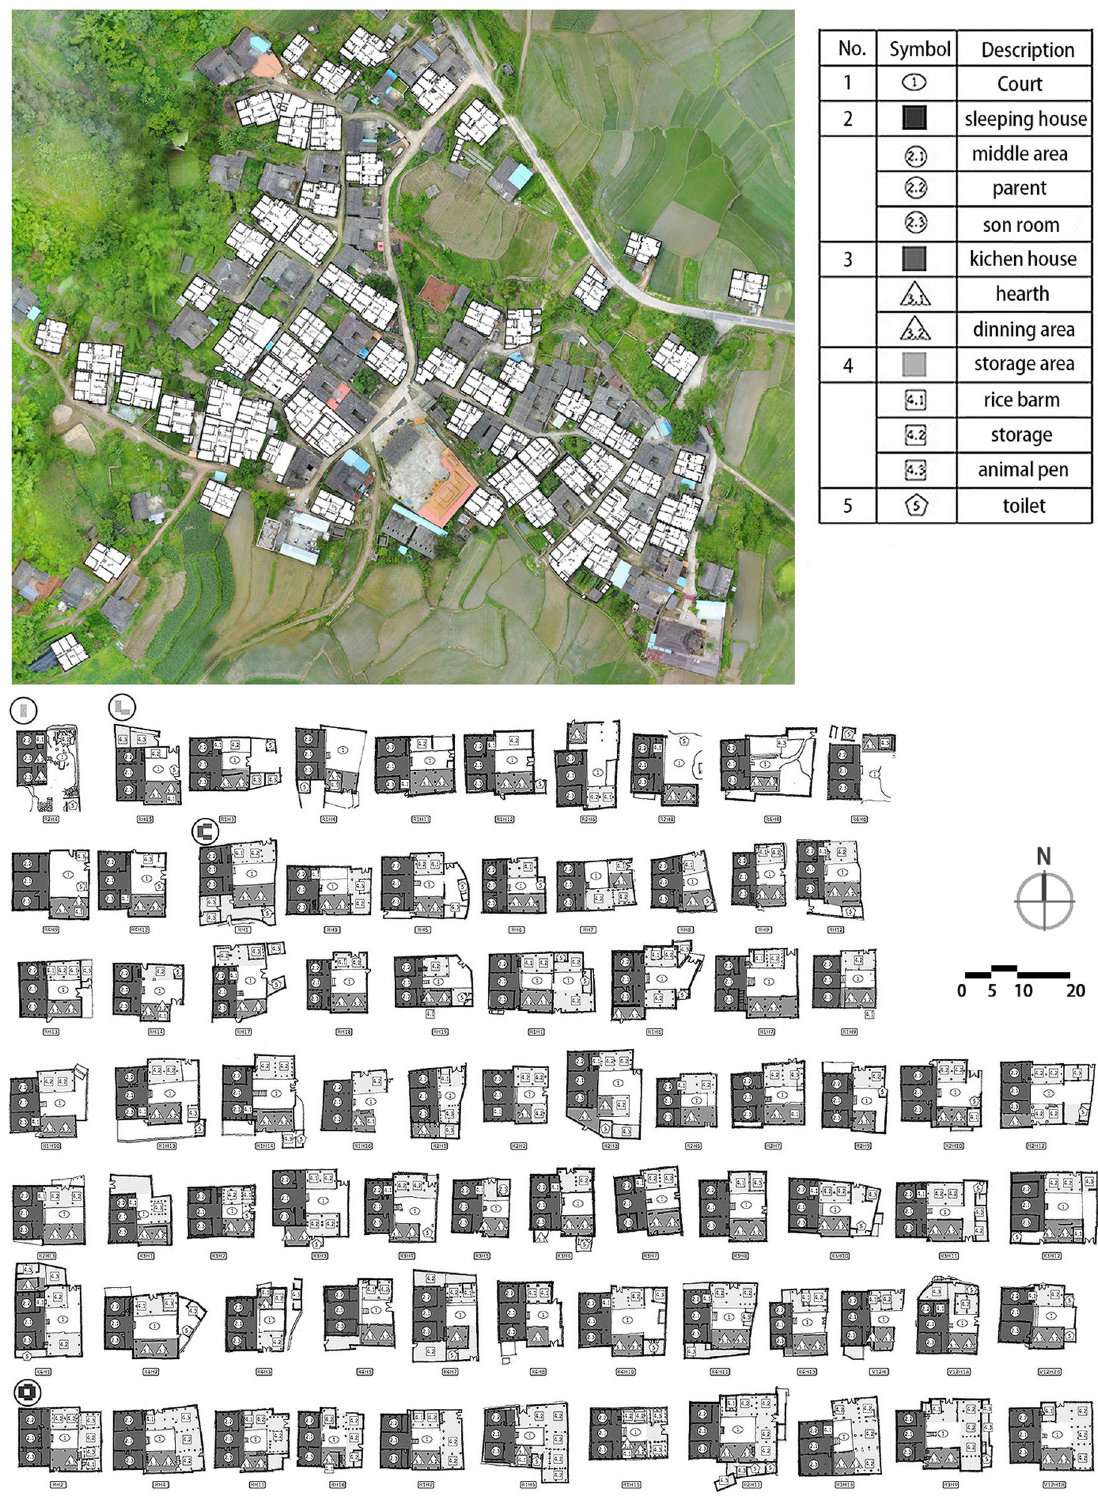
Fig. 4 Layout of a Dai village (top) and house plans (Source: the